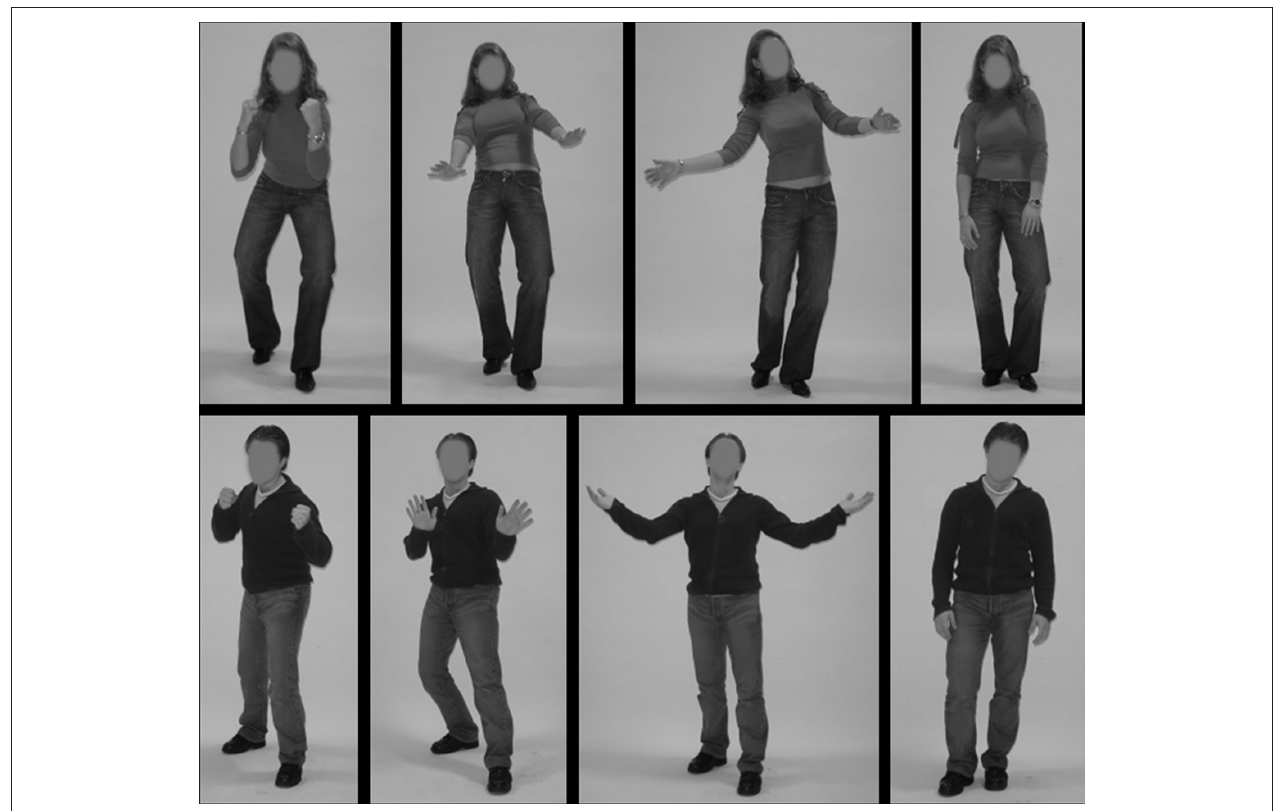
Figure 1 | examples of edited stimuli showing a female (top row) and male (bottom row) actor. The expressions display (from left to right): anger, fear, happiness,